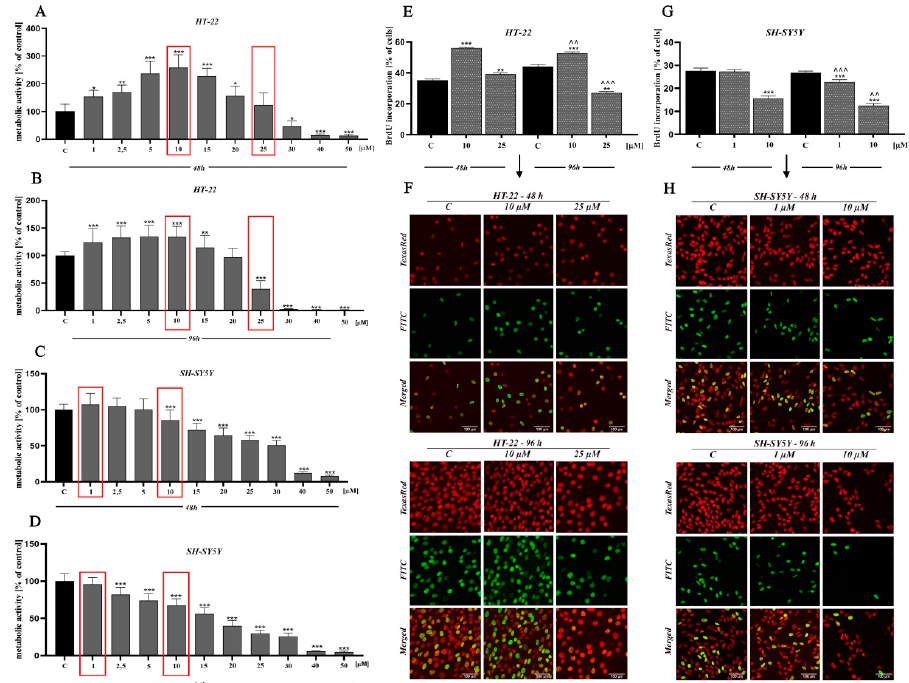
Figure 2. The effect of D2AAK1 on mouse hippocampal neurons (HT-22) and neuroblastoma cells (SH-SY5Y). Metabolic activity as measured with MTT assay with the selection of two concentrations for further investigation, marked in red frames ( A – D ) and BrdU assay ( E – H ) Red fluorescence-Texas Red, green fluorescence-FITC. Magnification of the objective lens 20×. Differences between control and test groups were assessed with one-way ANOVA and Dunnett a posteriori test. Bars indicate SD, n = 3, * p < 0.05; ** p < 0.01; *** p < 0.001 when compared between the control sample, not treated with the compound and the test sample incubated with the D2AAK1; ^^ p < 0.01; ^^^ p < 0.001 when compared between the incubation time (48 and 96 h).